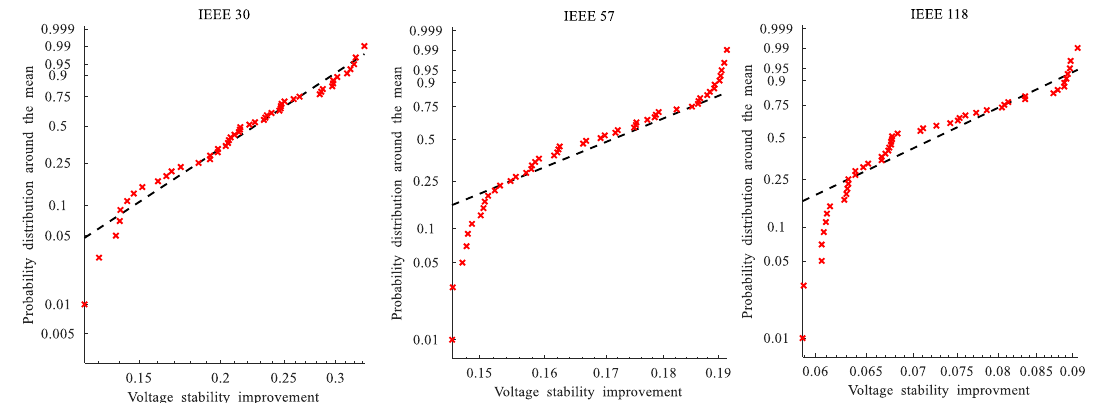
Figure 4. Convergence performance of the proposed algorithm on the IEEE 30 test system.